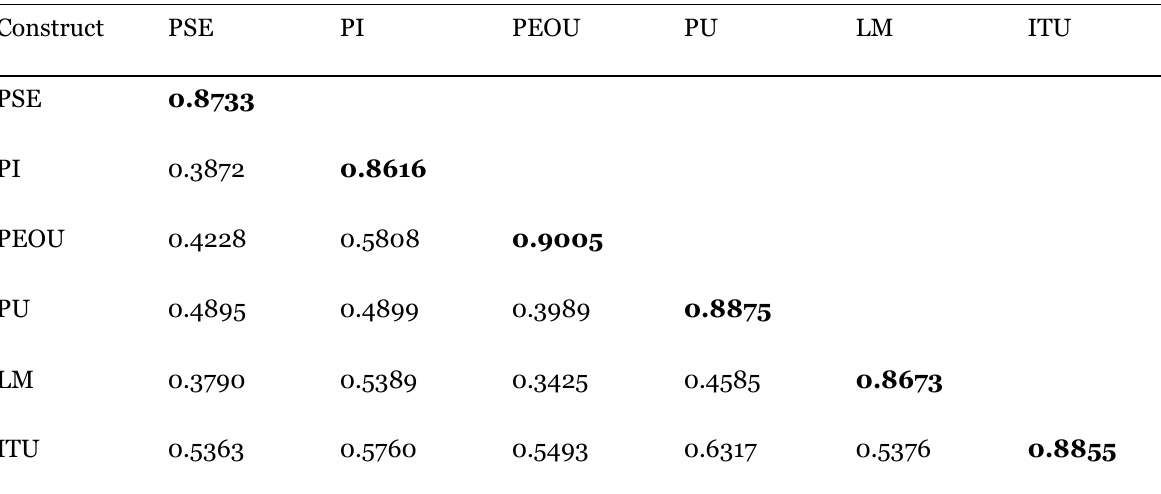
Discriminant Validity for the Measurement